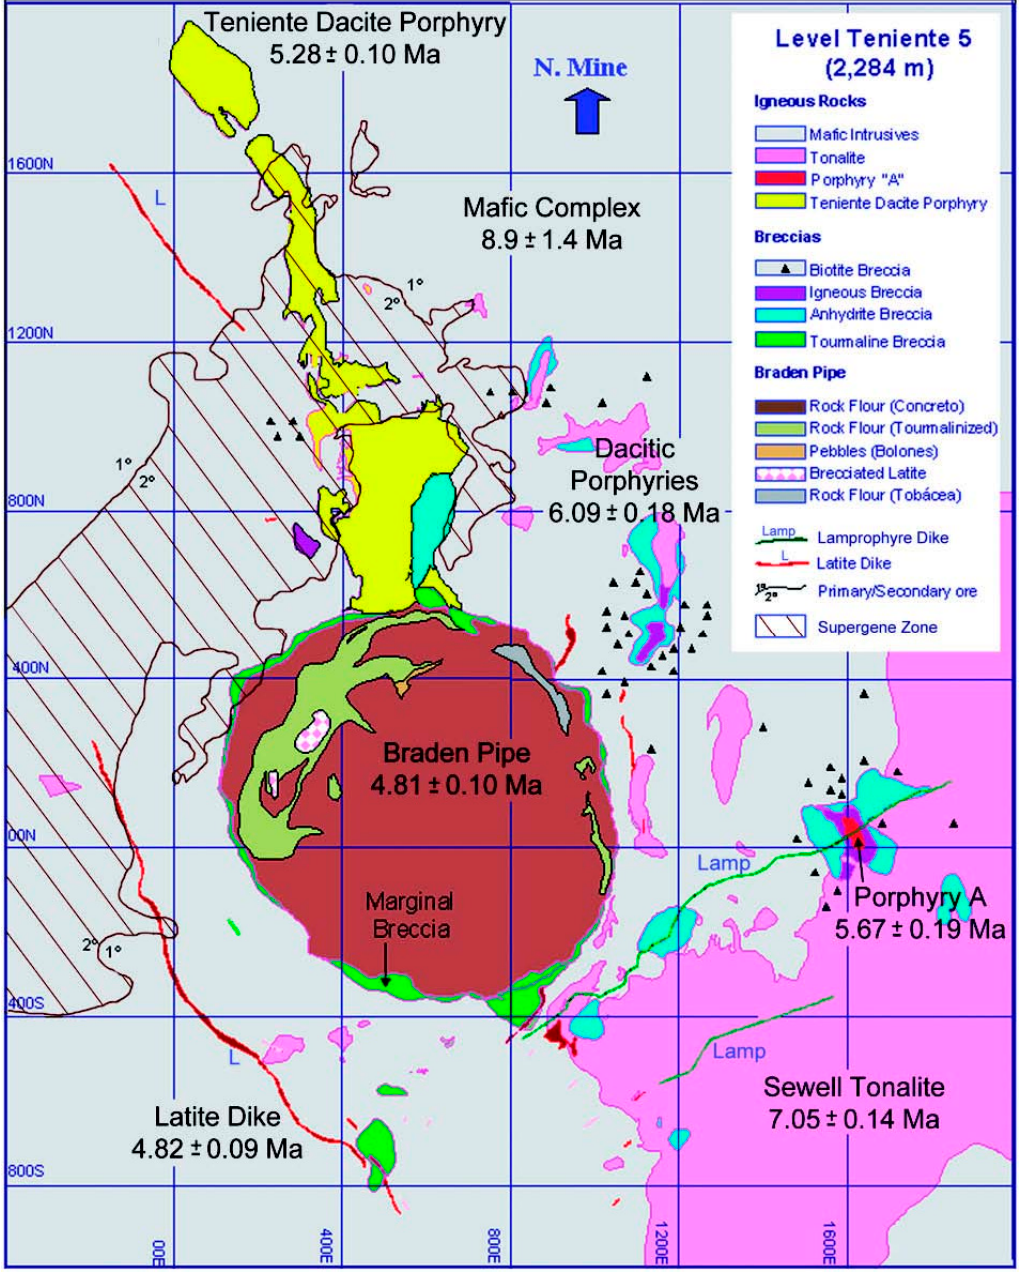
Figure 6. Geological map of level Teniente 5 (2284 m above sea level) in the mine [33,34]. The Dacitic Porphyries north of the Sewell Tonalite, are mapped as a distal portion of this pluton, although they are younger [35] and have an independent origin [37]. The spatial extent of biotite breccias is projected onto this level from where they have been mapped between levels Teniente 4 and 8. (Reprinted from Journal of Petrography, volume 52, Stern, C.R. et al., Magmatic evolution of the giant El Teniente Cu-Mo deposit, central Chile, page 1594, Copyright 2011, with permission from Oxford University Press).